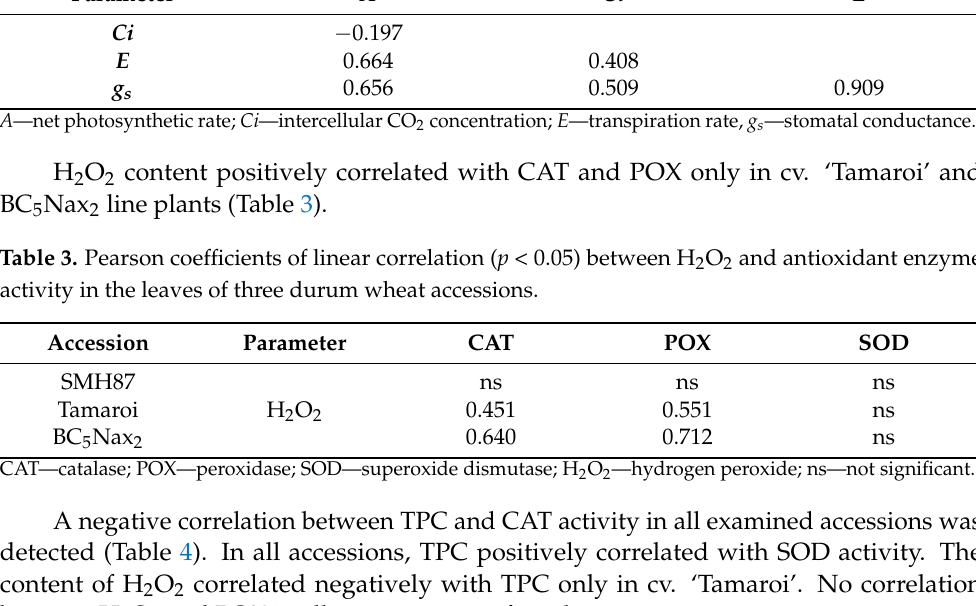
Table 2. Pearson coefficients of linear correlation ( p < 0.05) for gas exchange parameters. Parameter